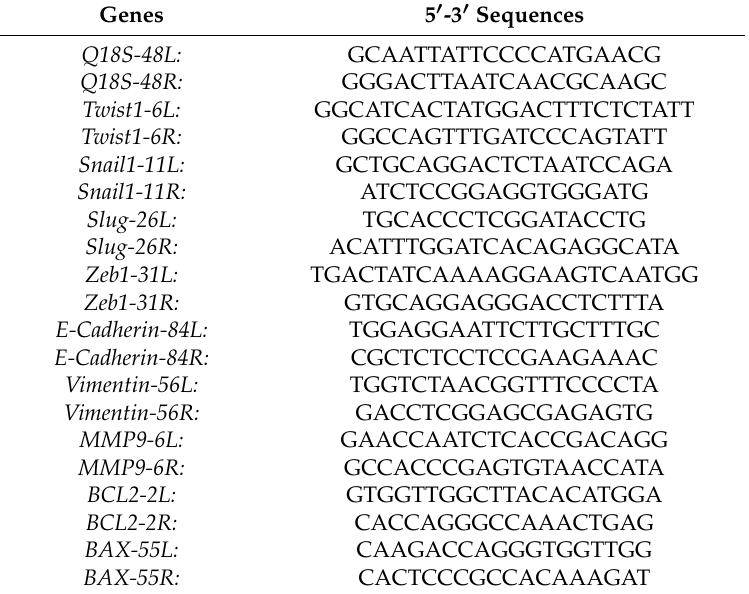
Table 1. Primer sequences for qPCR used for mRNA isolated from human cervical cancer cells.